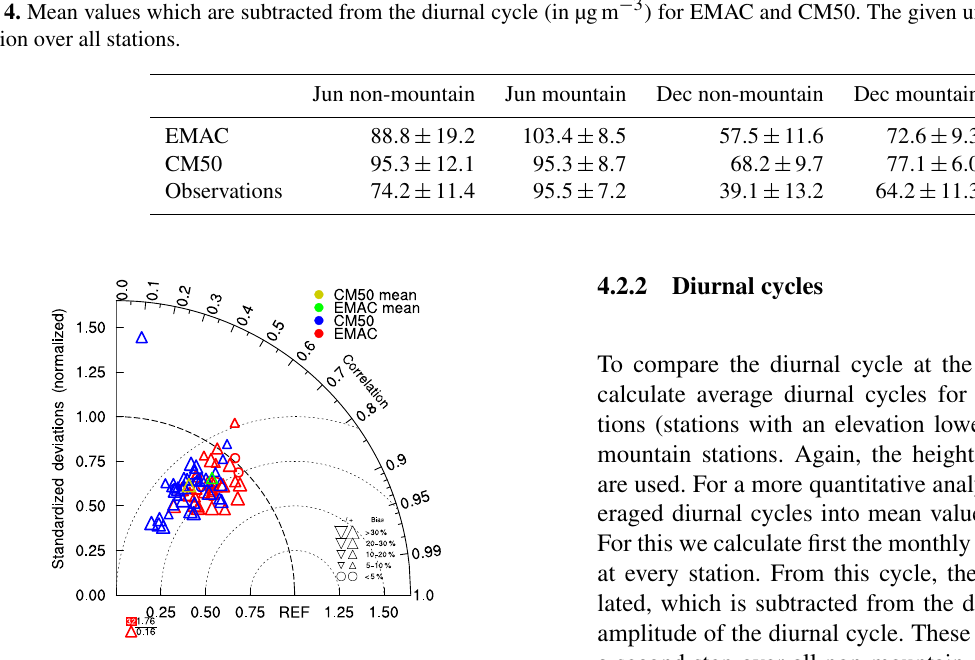
dard deviation are larger in EMAC (0.74) compared to CM50 (0.65). The same is true for the correlation coefficient which is 0.48 for EMAC and 0.34 for CM50. In general, the results at different stations in both models are similarly